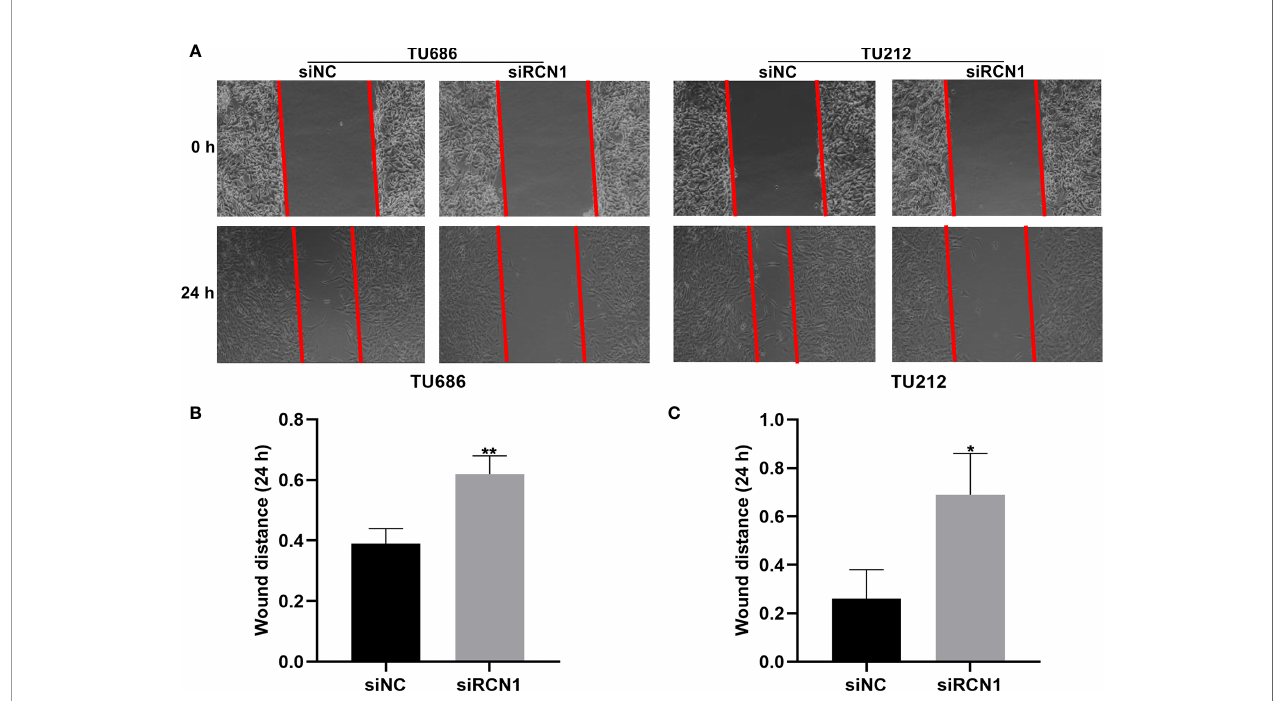
FIGURE 9 | RCNA1 knockdown restrains migration of laryngeal cancer cells. (A) Representative images of wound healing assay. (B, C) Quanti fi cation of wound distance of TU686 and TU212 cells transfected with siRCNA1. *P < 0.05; **p <